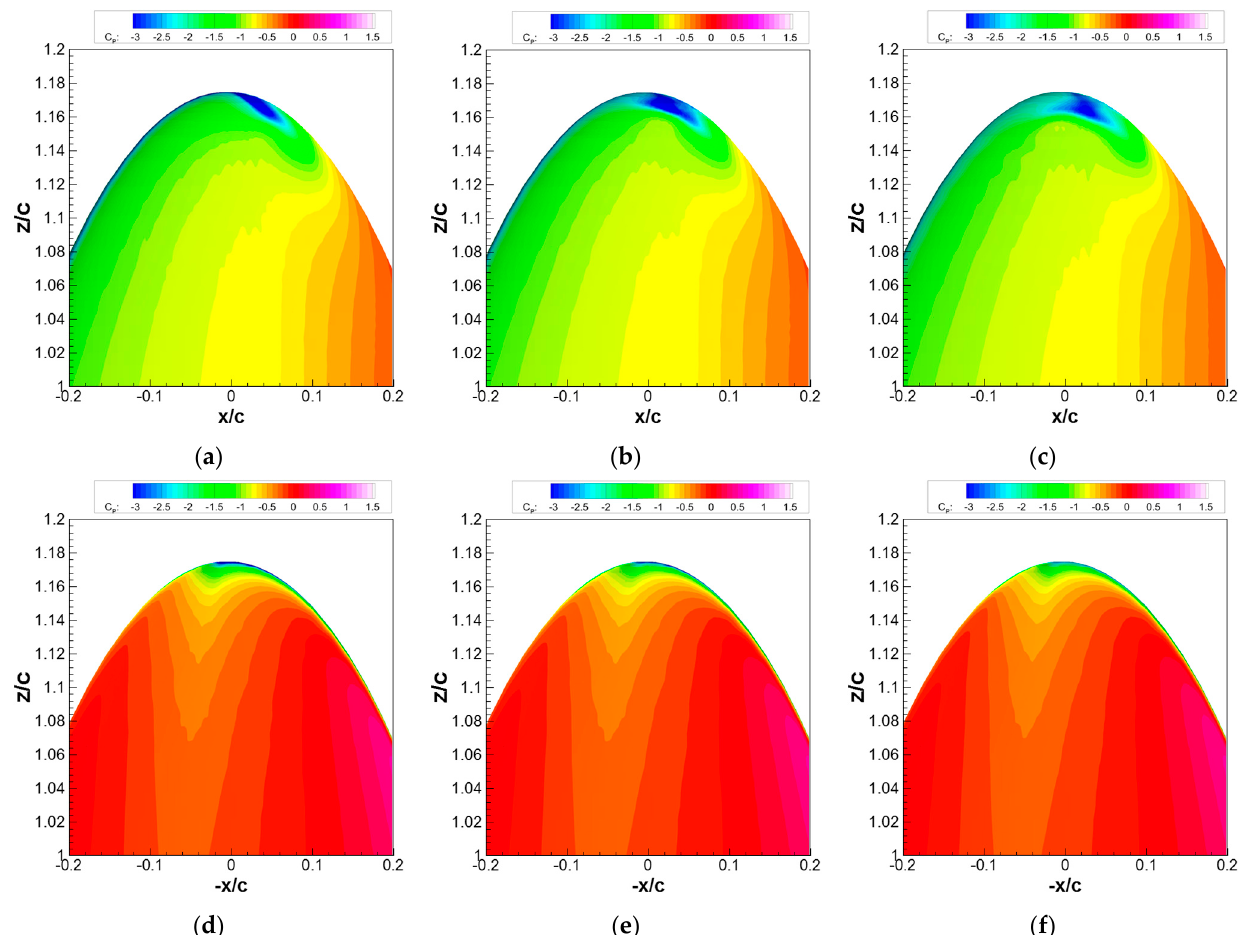
Figure 10. Limiting streamlines and wall shear stress distribution on the suction and pressure surfaces of the foil: ( a ) suction side, RKE; ( b ) suction side, SKW; ( c ) suction side, RSM; ( d ) pressure side, RKE; ( e ) pressure side, SKW; ( f ) pressure side, RSM.